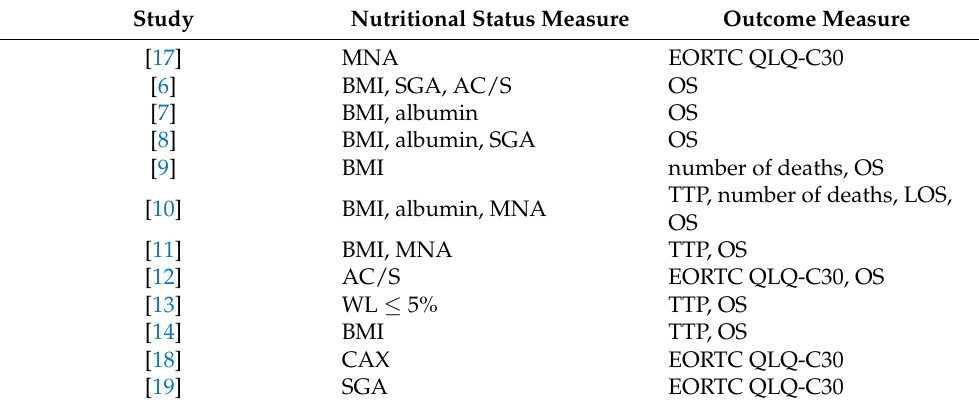
Table 2. Methods for assessing the nutritional status and quality of life used in the included studies. Study Nutritional Status